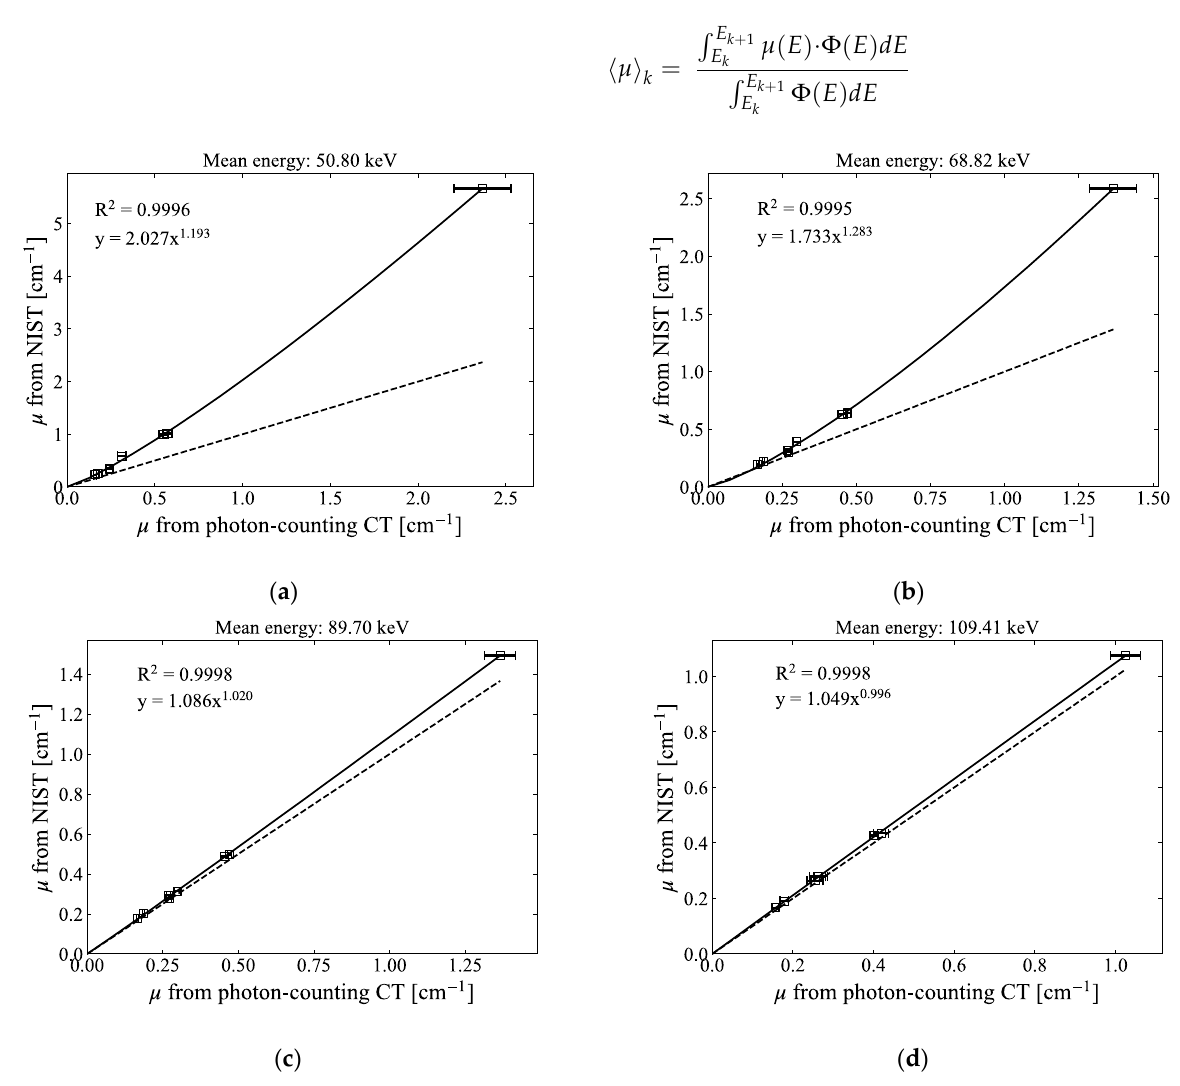
Figure 7. Linear attenuation coefficients obtained from photon-counting CT and those calculated using Equation (17) from NIST values for ( a ) threshold one, ( b ) threshold two, ( c ) threshold three, and ( d ) threshold four. Solid lines are results of fitting to a power function, and broken lines indicate the same values for x- and y-axes (Slope = 1). Mean energy was calculated using Equation (16).